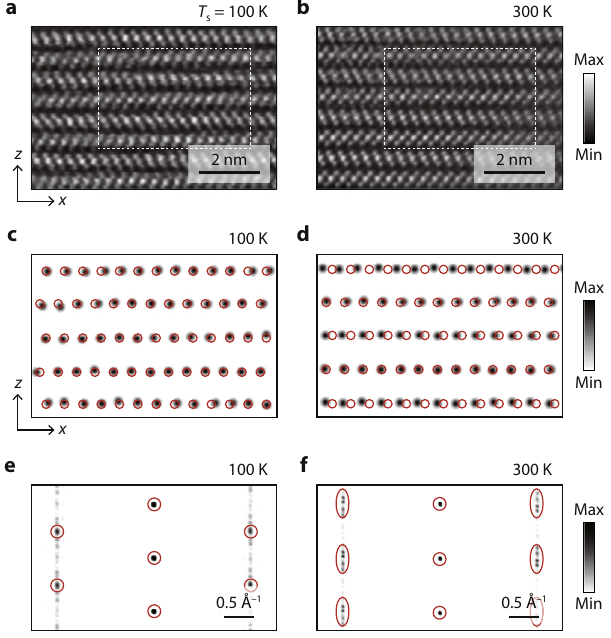
Fig.3|Atomic-resolutionimagingaboveandbelow T c .a , b HAADF-STEMimages of PbI 2 at ( a ) 100K and ( b ) 300K taken along the y axis. c , d Distribution of Pb atoms taken by the curve fi t to large bright protrusions in the dashed box of a , b with the 2D Gaussian function. Red open circles mark the location of Pb atoms expectedfor4H-PbI 2 . e , f Fourier-transformimagesofthosein c , d overtheareaof 10 × 10 nm 2 . Red circles in e indicate the major reciprocal lattice peaks, and red ovals in f indicate those spread along the z axis. Source data are provided as a Source Data fi le.